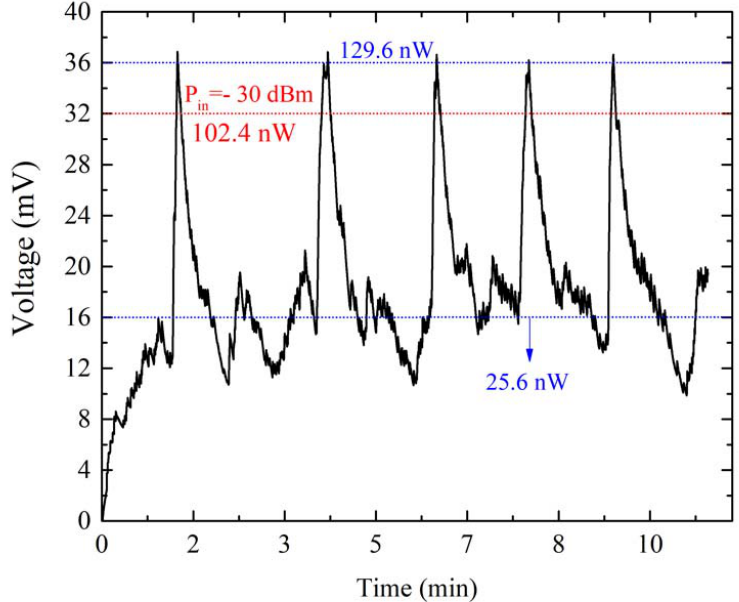
Figure 9. Measured output voltage in the 10 k Ω output resistance produced by the ambient RF energy harvesting. The red line indicates the voltage and power level corresponding to a − 30 dBm input power. The blue lines indicate the maximum and minimum voltage and power supplied by the RF harvesting system.